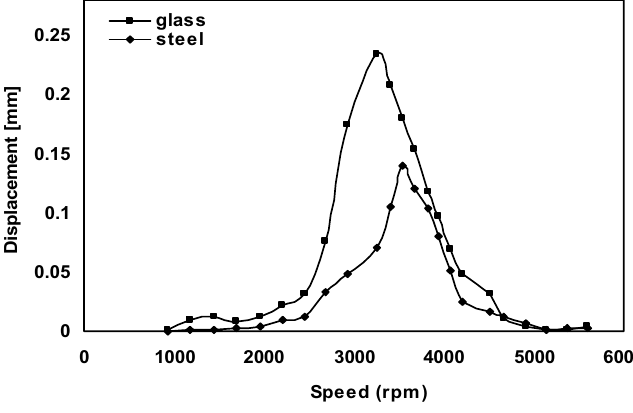
Fig. 9. Damper material effect on vibration amplitude (L/D =